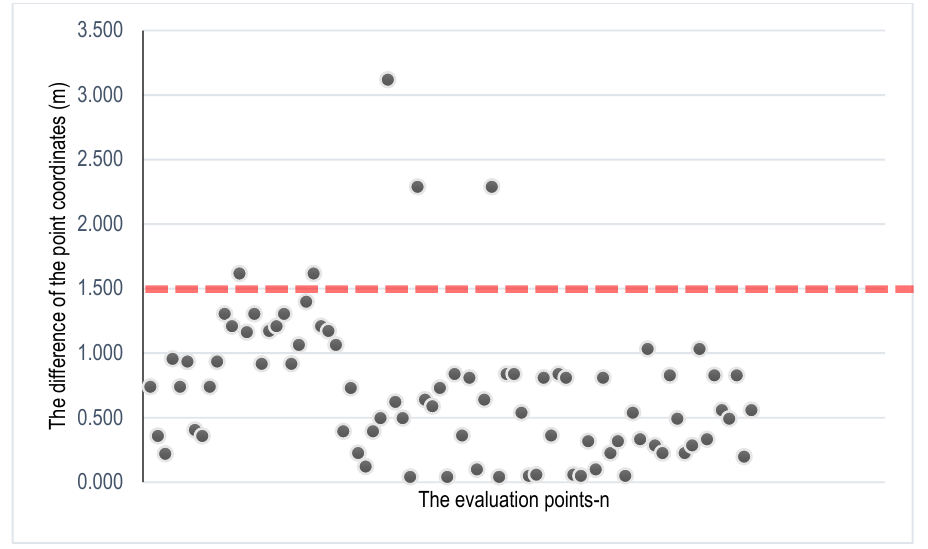
Figure A2. Positional accuracy (in meters) plotted as a shifting of points between the reference and evaluation data of parcels in residential areas in Grobogan.